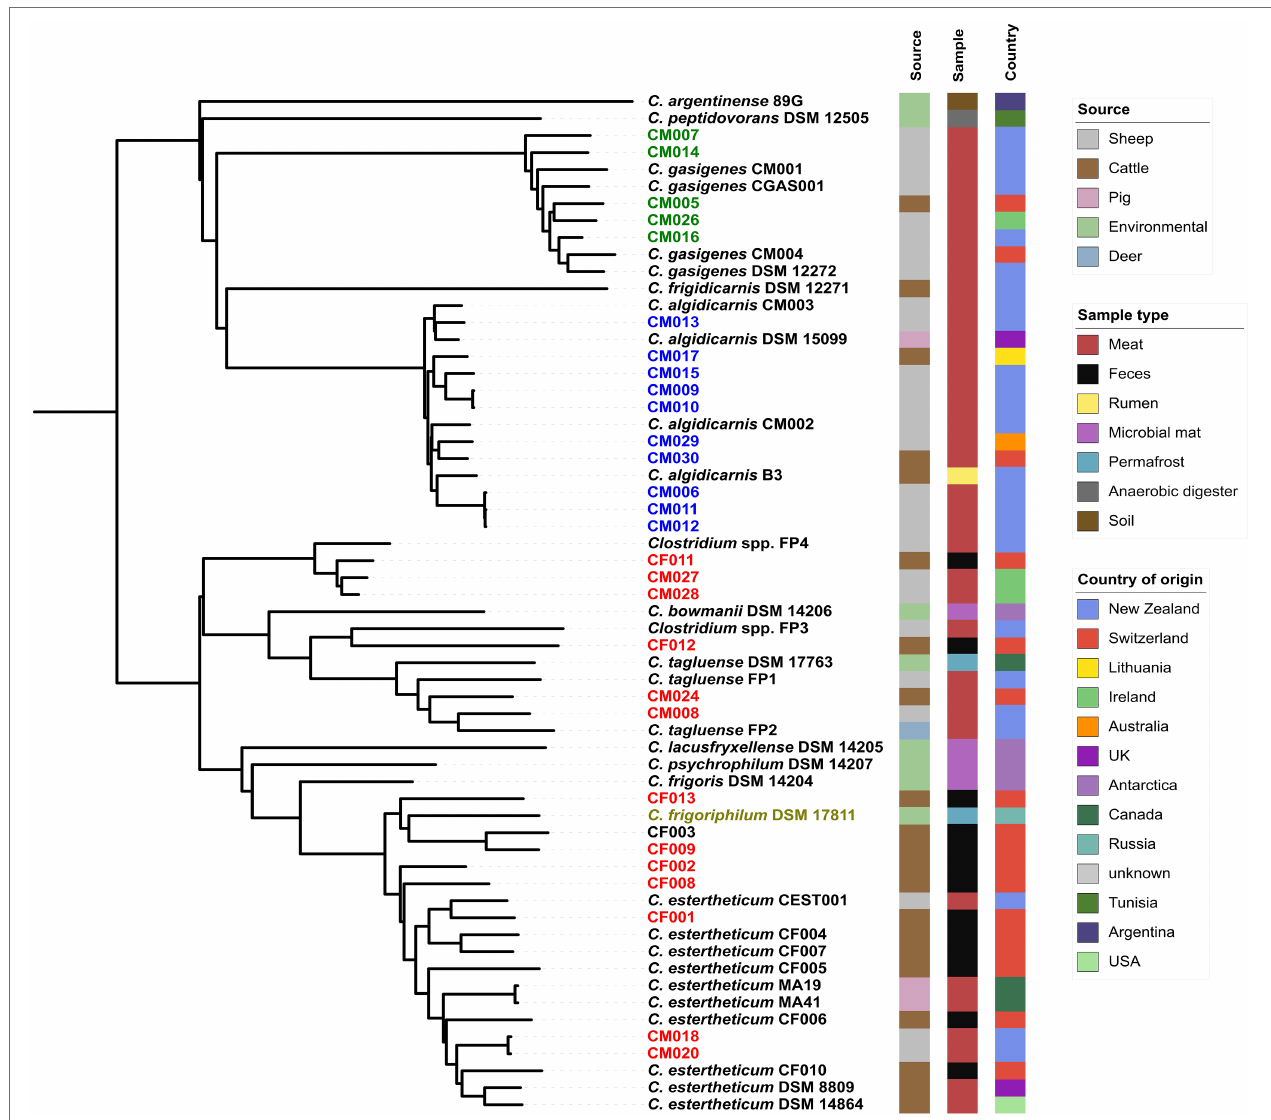
FIGURE 2 | Pan-genome phylogenomic tree of 28 Clostridium spp. strains isolated from MJS and BFS and 32 representative clostridia strains. Thirteen isolates (red) clustered within the CEC. Other isolates clustered within species C. algidicarnis (blue text; n = 10) and C. gasigenes (green text; n = 5). C. frigoriphilum DSM 17811 is highlighted in olive. On the right of the tree are metadata of the 60 clostridia